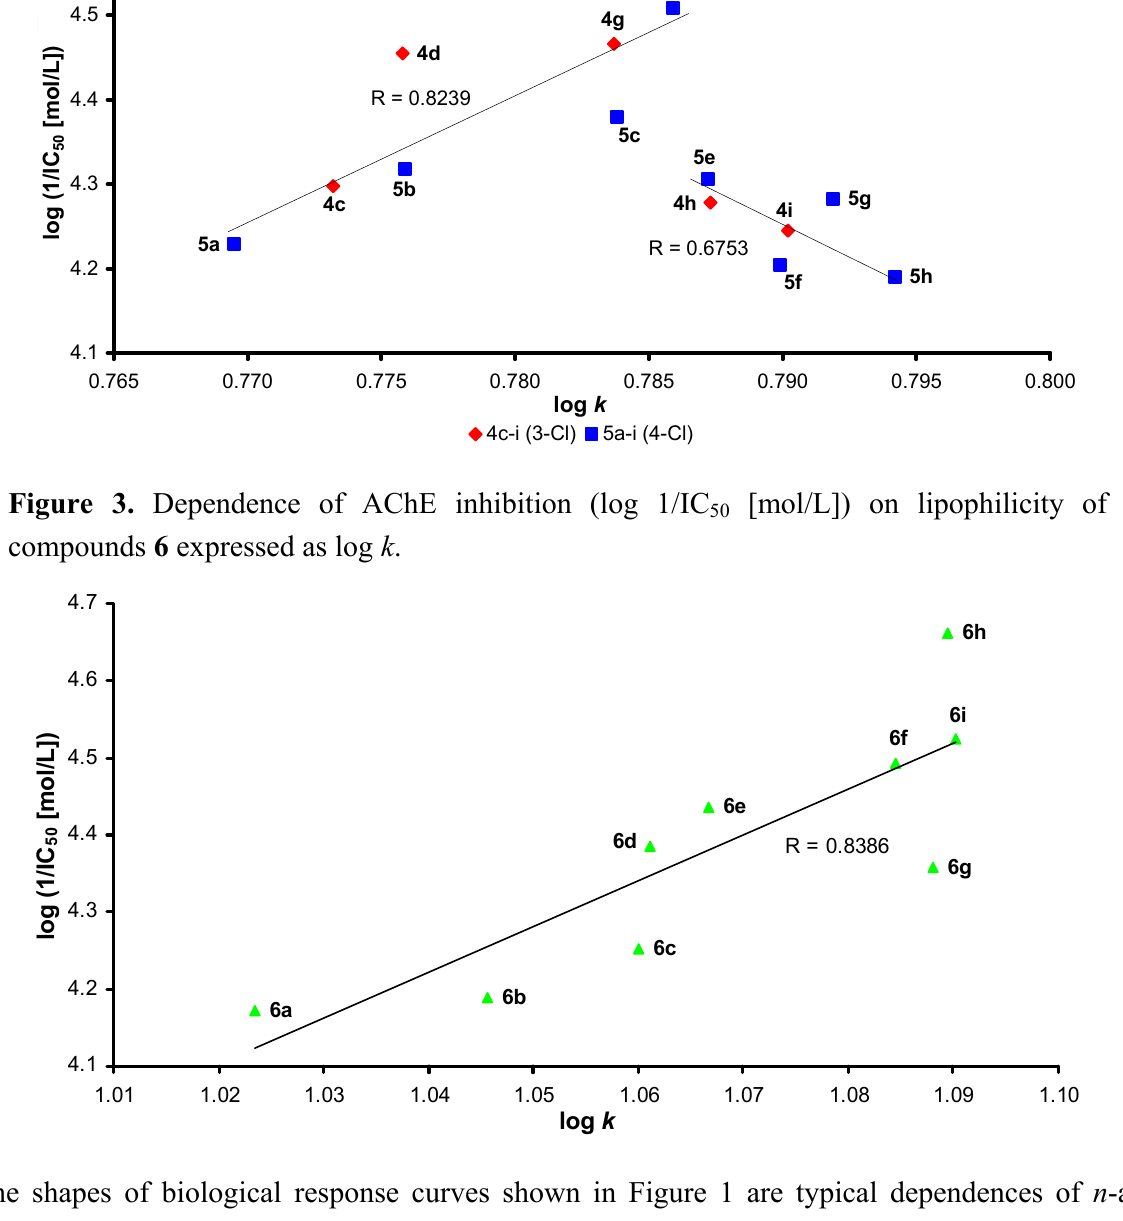
Figure 2. General dependences of AChE inhibition (log 1/IC of compounds 4 and 5 expressed as log k . Compounds 4e , 4f and 5i were excluded/are not plotted.